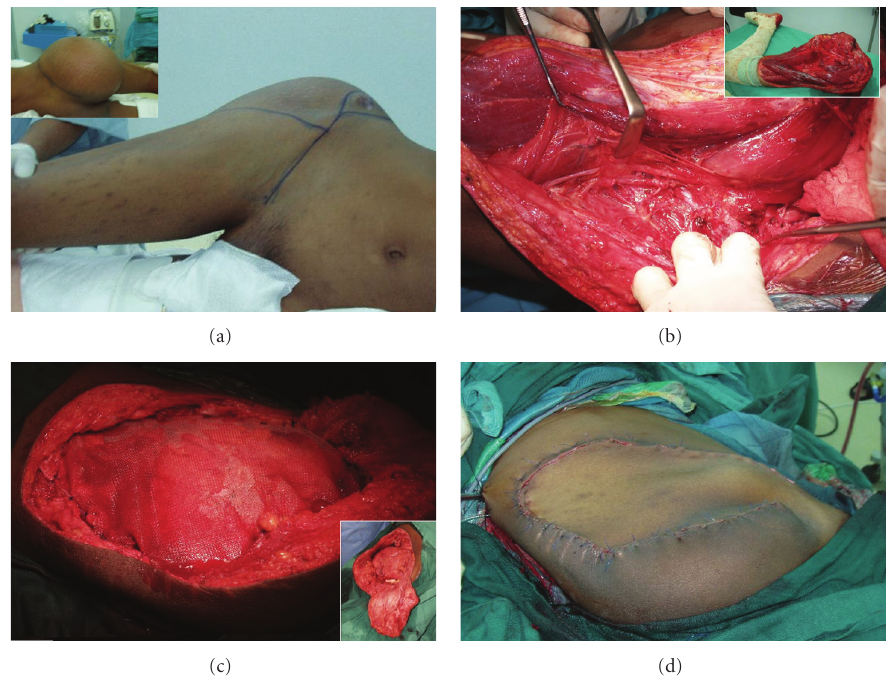
Figure 2: 19-year-old man with a diagnosis of peripheral primitive neuroectodermal sarcoma. He had right hemipelvectomy and reconstruction with mesh and anteromedial fasciocutaneous flap based on perforators from superficial femoral vessels. (a) Pre-op photo of the large swelling over the hip and gluteal areas. (b) Dissection of the pedicle showing the intact cutaneous perforators to the skin. Inset- amputated limb showing area where the flap has been raised. (c) Peritoneal cavity is supported with mesh. Inset shows defect and the flap. (d) Immediate post op photo showing the flap